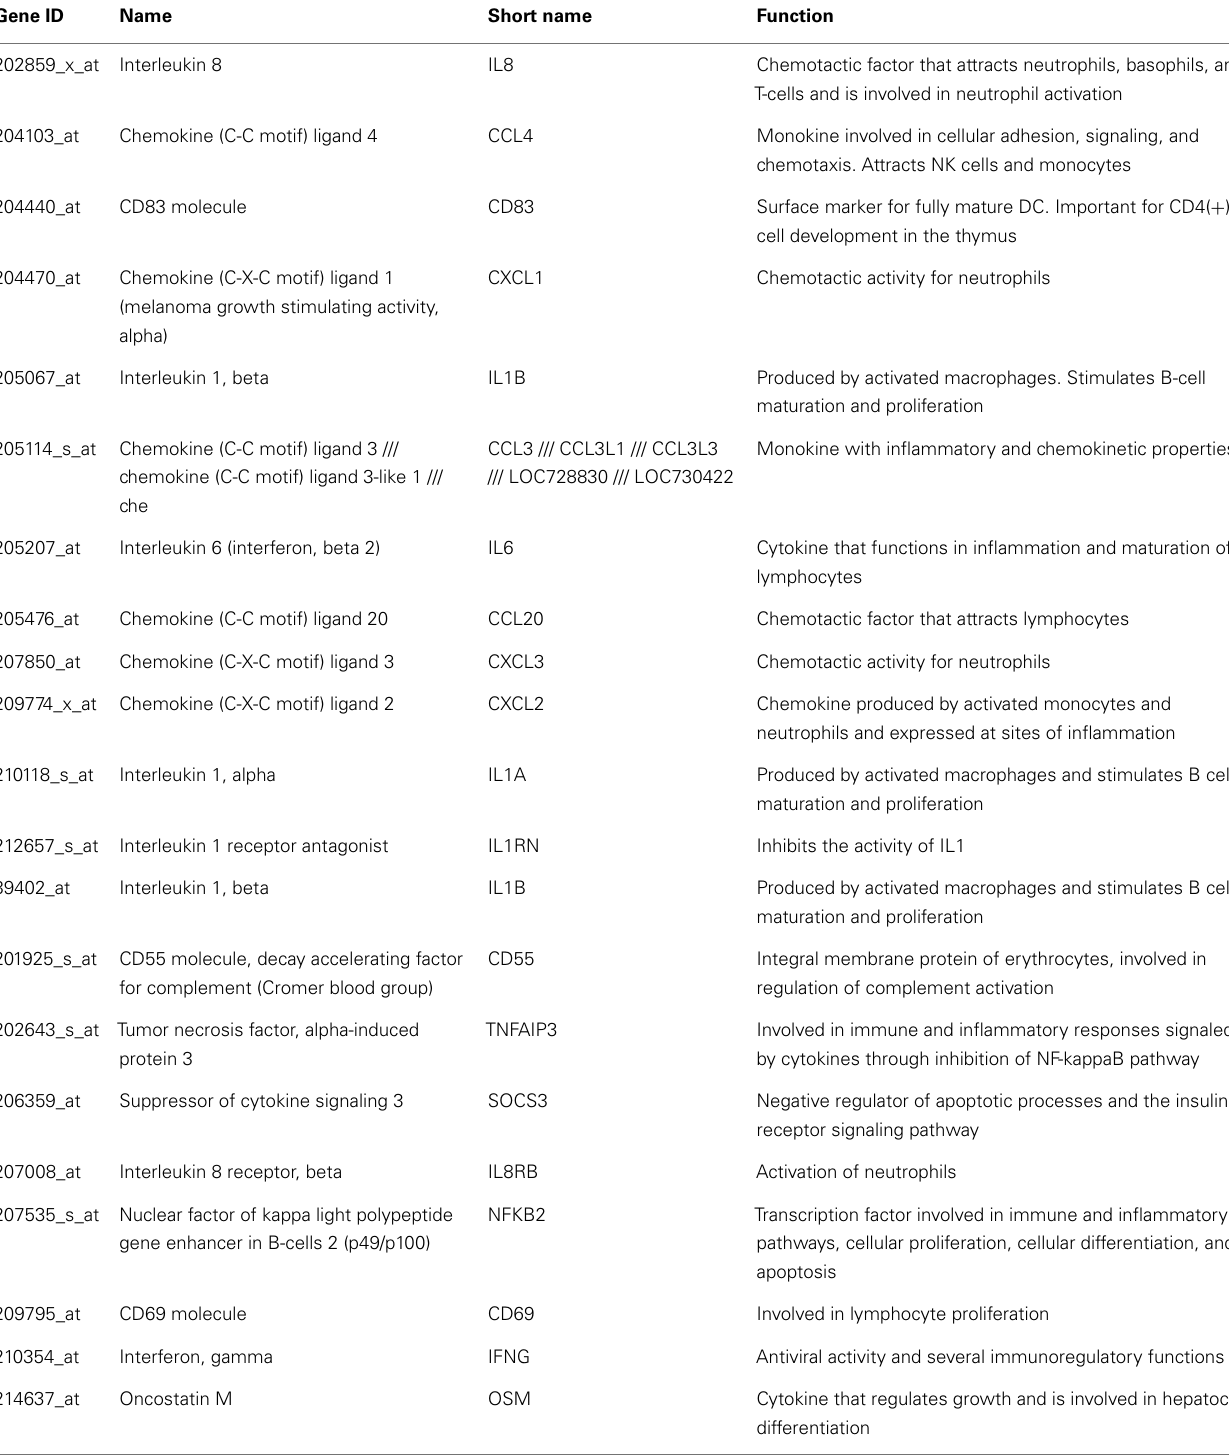
TableA2 | Genes upregulated in HCV monoinfected subjects